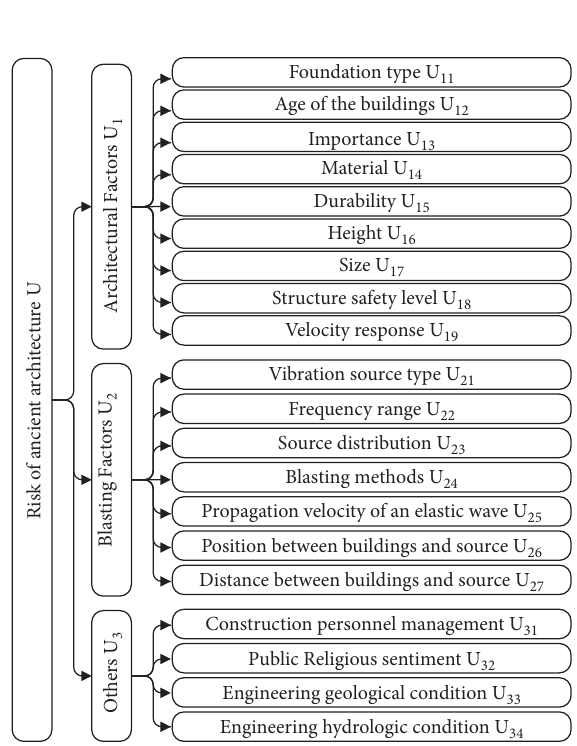
Figure 4: Risk scales.